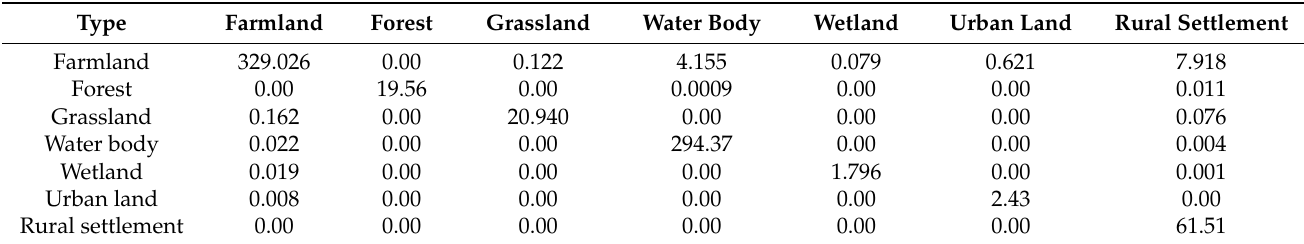
Figure 7. Simulation of different scenarios of land use in the Chaohu Peninsula. Table 5. Land use transfer matrix under BM scenario (km 2 ).